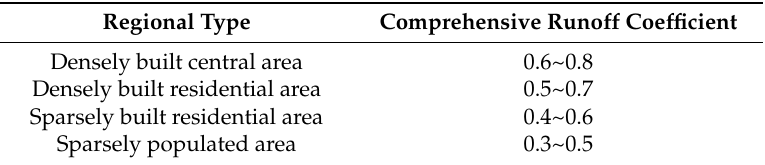
Table 2. Empirical values of regional comprehensive runoff coefficient.